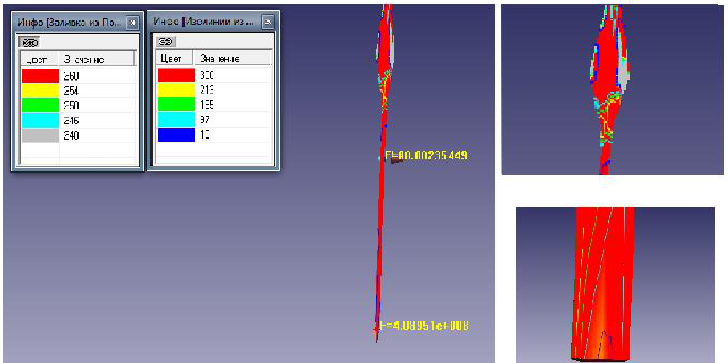
Fig. 3. The results of modeling of liquid-abrasive mixture with the walls of the calibration tube